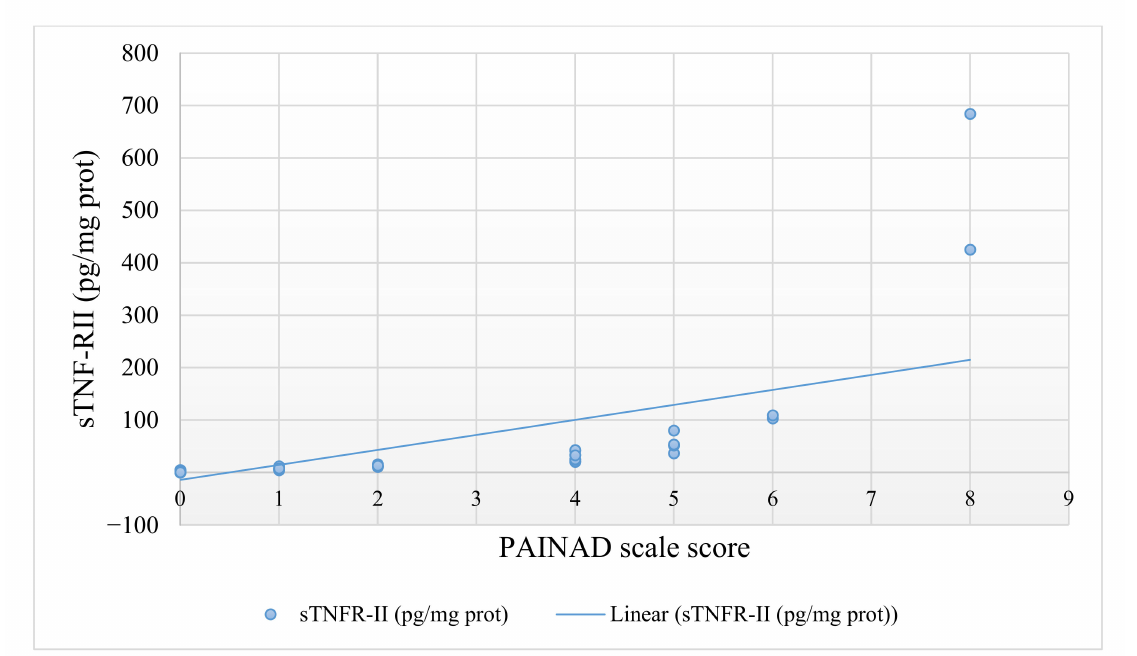
Figure 1. Association between PAINAD numerical score and sTNF-RII (pg/mg protein) values.